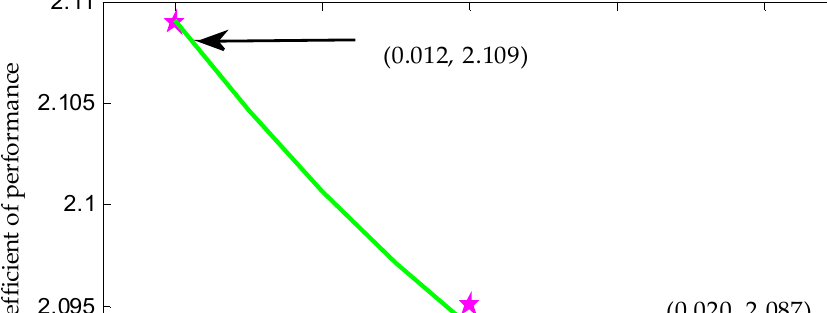
Figure 16. Optimal ECOP varying with operating pressure.